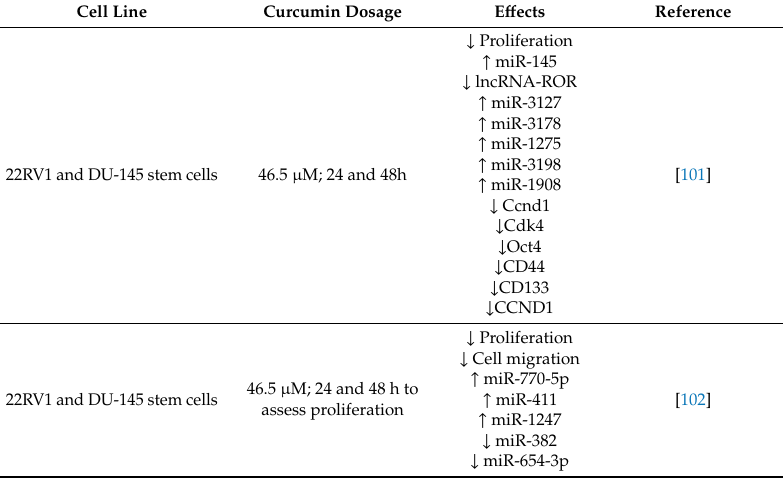
Table 5. In vitro evidence of the e ff ects of curcumin on prostate cancer stem cells. Cell